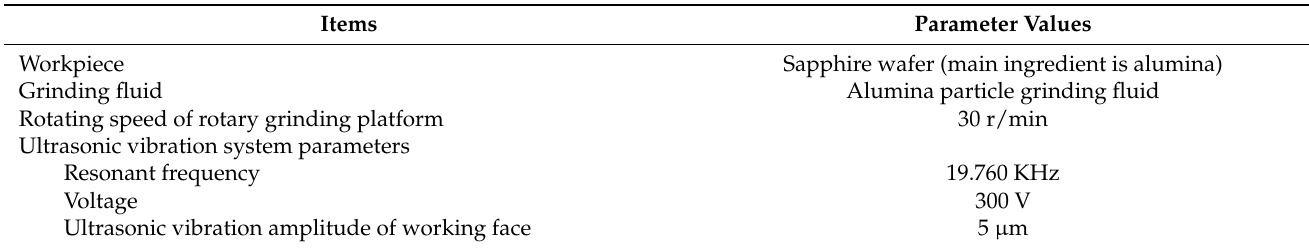
Figure 6. Experiment diagram of non-contact ultrasonic grinding sapphire. Table 2. Experimental